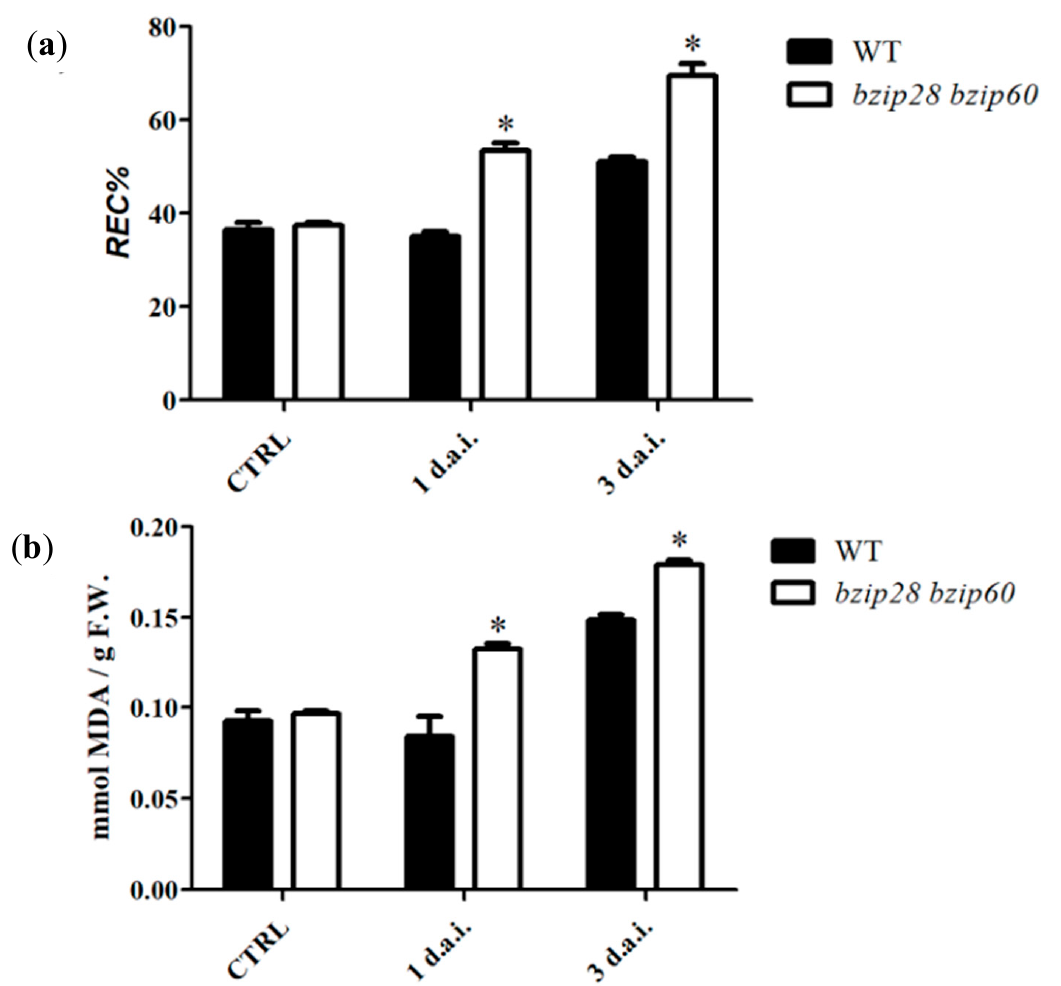
Figure 2. Ion leakage ( a ), and lipid peroxidation ( b ) of leaves from WT and bzip28 bzip60 Arabidopsis plants infected by D. gigantea . Leaves of WT and bzip28 bzip60 mutant plants were sprayed with a suspension of D. gigantea conidia (500,000 /mL) and then collected 1 and 3 d.a.i. Ion leakage and membrane lipid peroxidation were determined as REC% and MDA content, respectively, as reported in Sections 2.4 and 2.5. The results represent mean values ± SD ( n > 10). Statistical significance was attributed by Student’s test (* p <